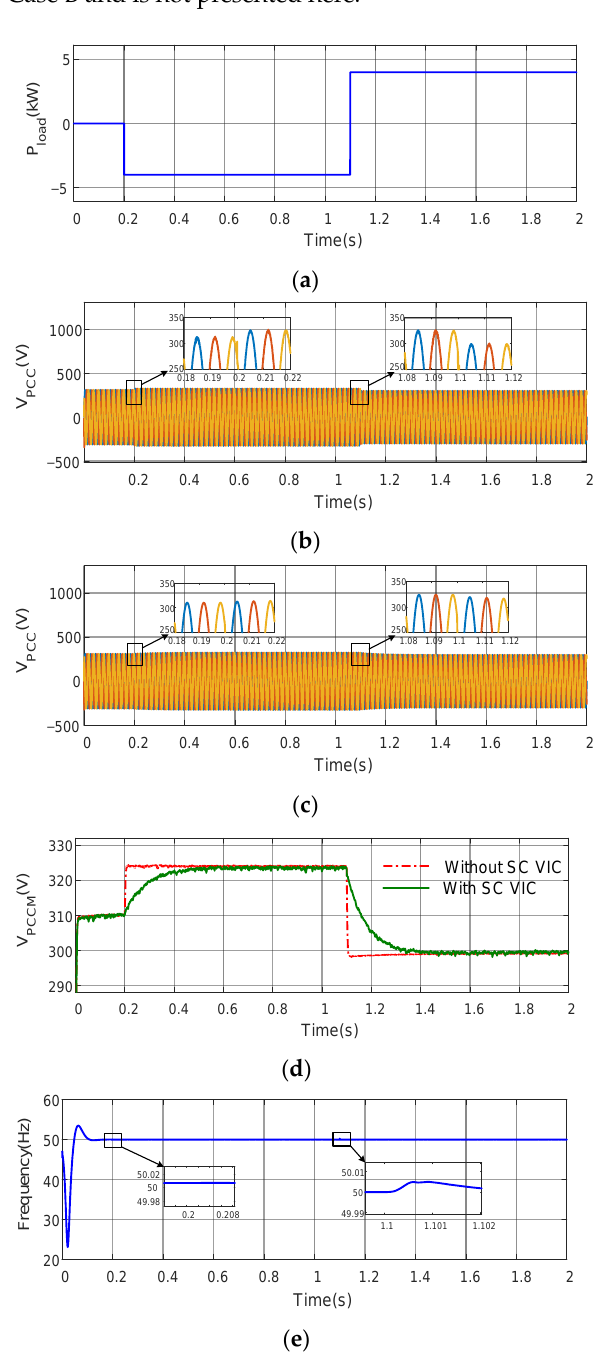
Figure 11. AC bus voltage response with P-V droop and virtual inertia control under load fluctuation. ( a ) Equivalent load power; ( b ) PCC voltage waveform without SC VIC; ( c ) PCC voltage waveform with SC VIC; ( d ) comparison of PCC voltage magnitude; ( e ) frequency at PCC.